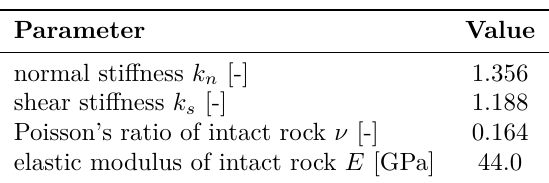
Table 2. Parameters of Oda’s parallel plate model.